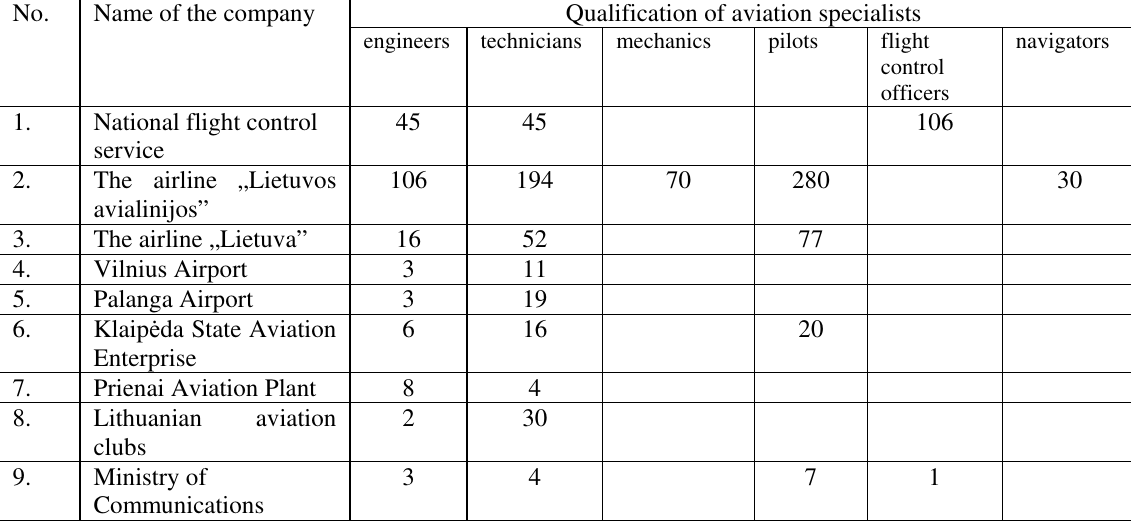
Table 1. Aviation specialists in civil aviation enterprises in 1993